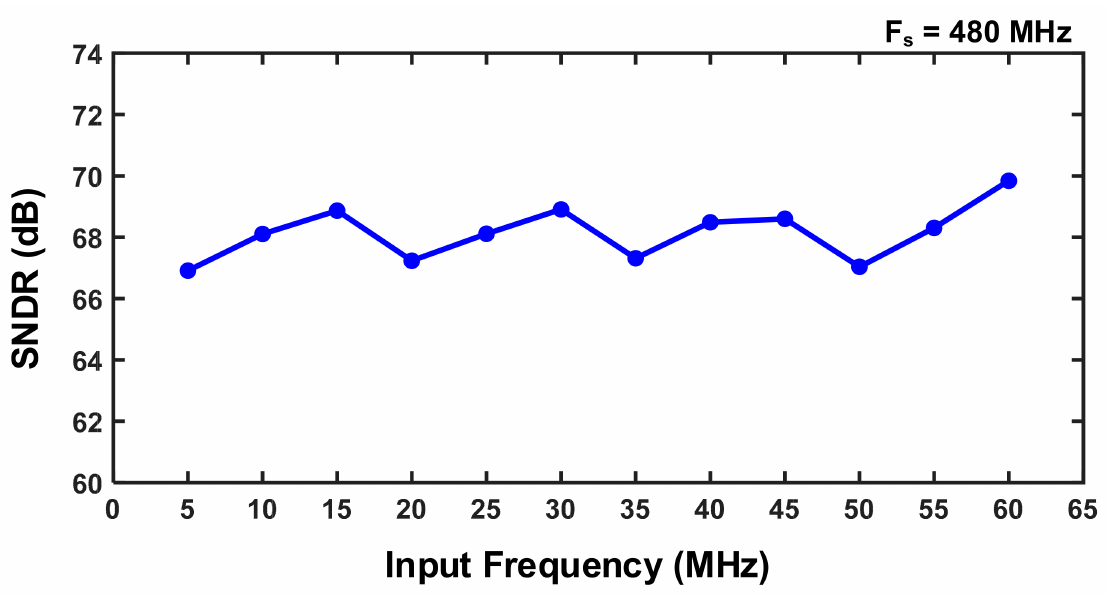
Figure 13. Simulated SNDR versus input signal frequency at 480 MS/s.